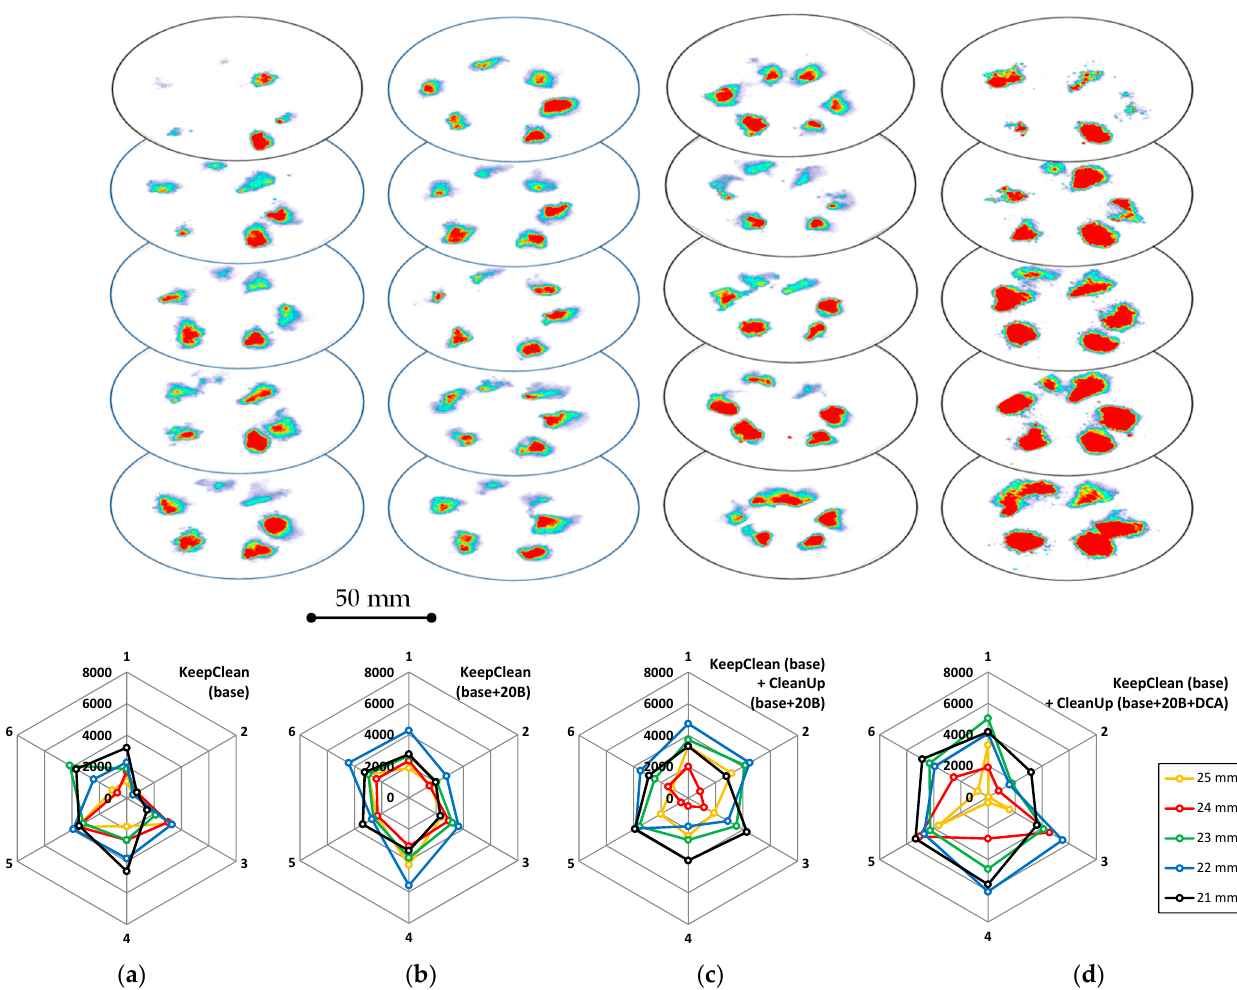
Figure 10. Cross ‐ sectional view of the jet ( a – d ) and area analysis (below) of individual fuels after Keep ‐ Clean and CleanUp tests: ( a , b ) tests lasting 48 h and ( c , d ) tests lasting a total of 72 h.